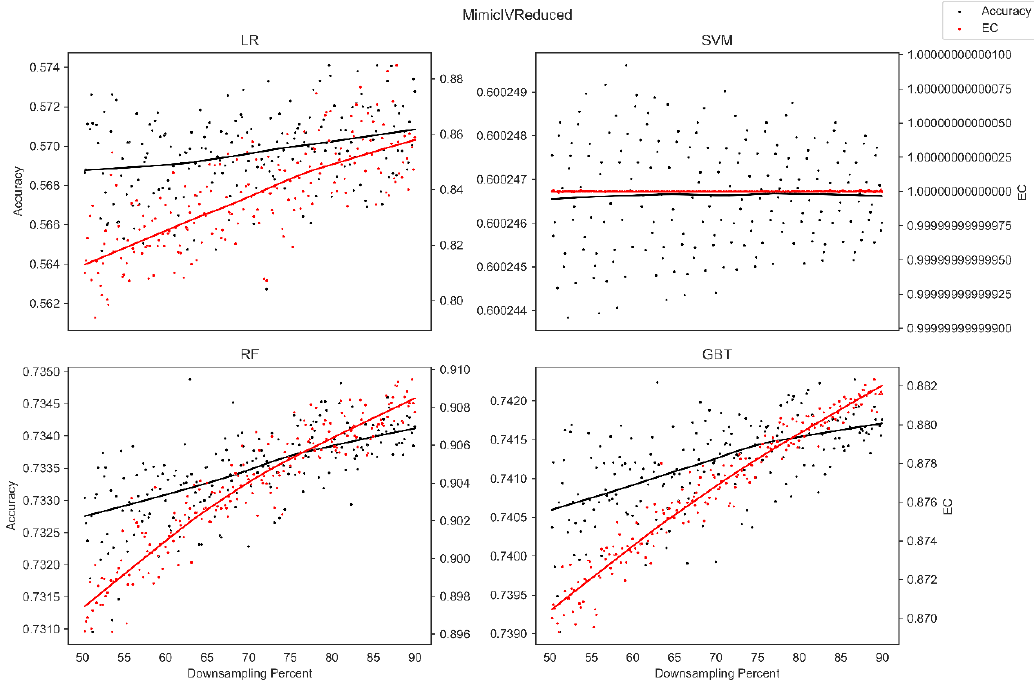
Figure 6. Average error consistency and overall accuracy vs. varying sample size percentages (down-sampled) from the MIMIC IV dataset. Trend lines were established with locally weighted regression and smoothing [25].